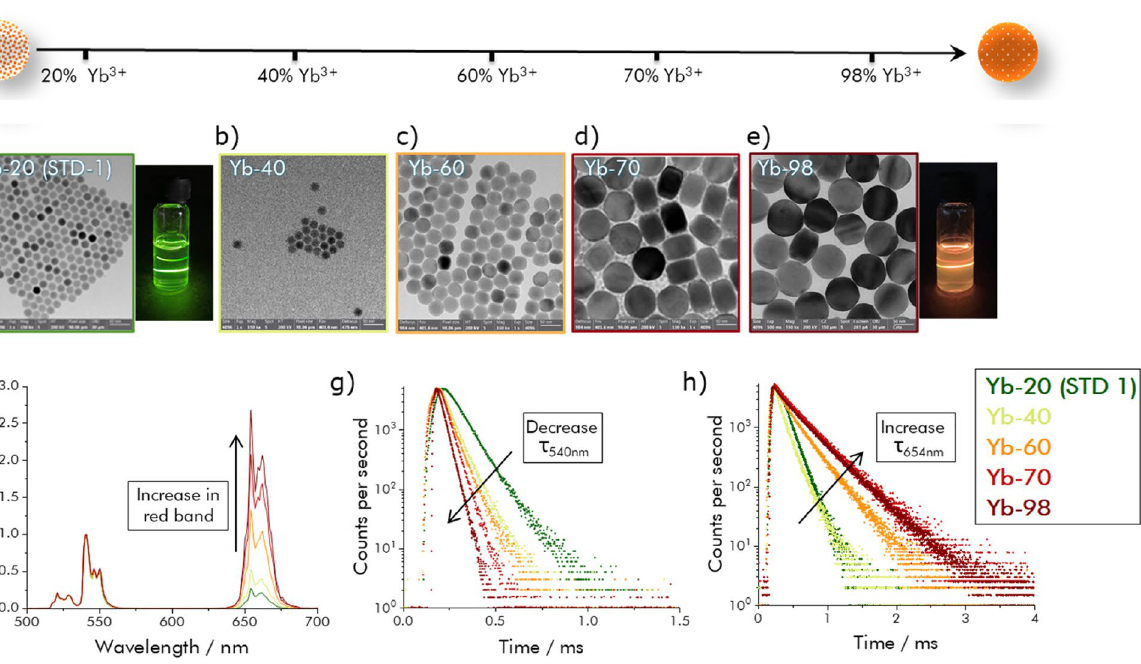
Fig. S1a,s–v. The photographs in the insets show the visible emission of each sample under 980 nm excitation; ( f ) UCL emission spectra of